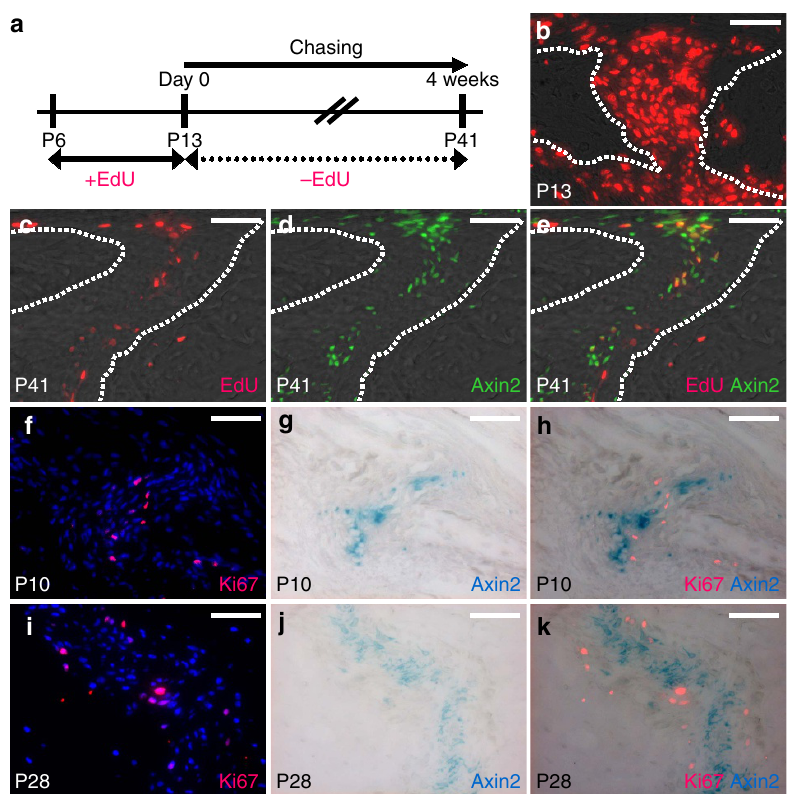
Figure 1 | Slow cycling cells expressing Axin2 reside in the midline of the suture mesenchyme. ( a ) An illustration describes pulse-chase labelling analysis for identification of label-retaining cells. Sections of the pulse-chased Axin2 GFP skull were analyzed by EdU staining before ( b ) and after the 4-week chase period ( c ), at P13 and P41, respectively. ( d ) The Axin2-expressing cells were detected by GFP. ( e ) Merged imaging examines cells positive for EdU and Axin2 expression. Sections of the skull were analyzed for cells active in mitotic division and expressing Axin2 by immunostaining of Ki67 and b -gal staining of lacZ, respectively, at P10 ( f – h ) and P28 ( i – k ). Images are representations from three independent experiments. Scale bar, 50 m m ( b – k